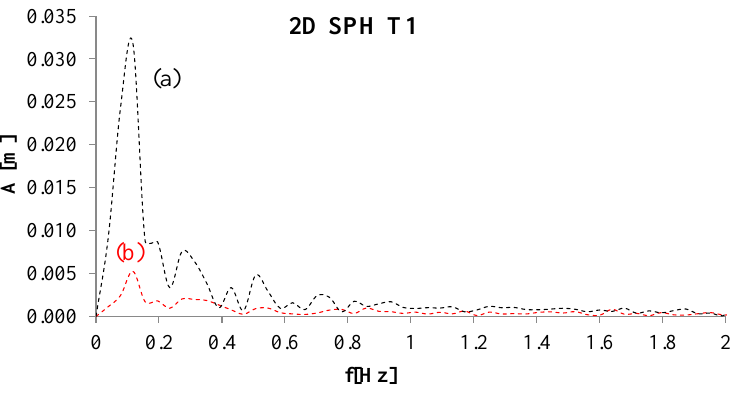
Figure 13. Test T1: Amplitude spectrum of the time series of the surface elevations: ( a ) upstream; and ( b ) downstream of the jump.